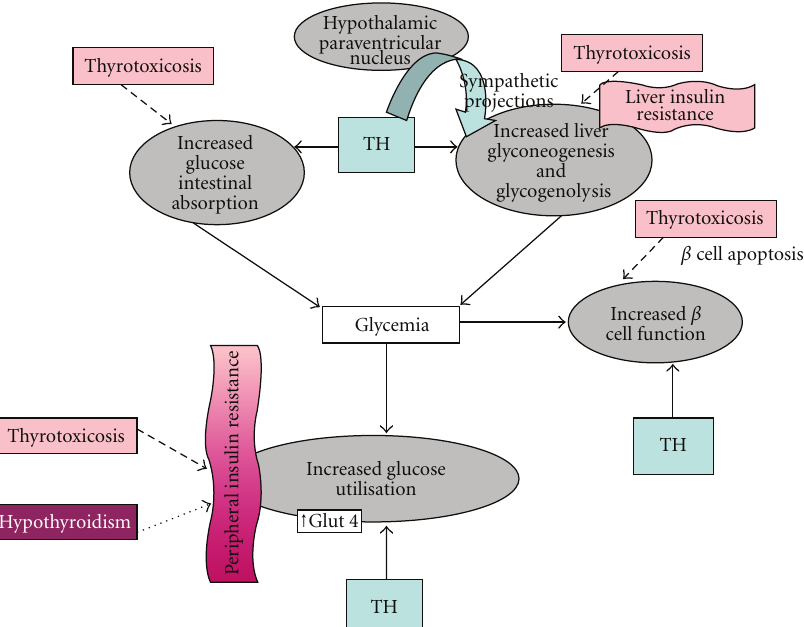
Figure 1: E ff ects of thyroid hormones on glucose metabolism in euthyroid (solid lines), hyperthyroid (rough-dashed lines), and hypothyroid conditions (fine-dashed lines). TH: thyroid